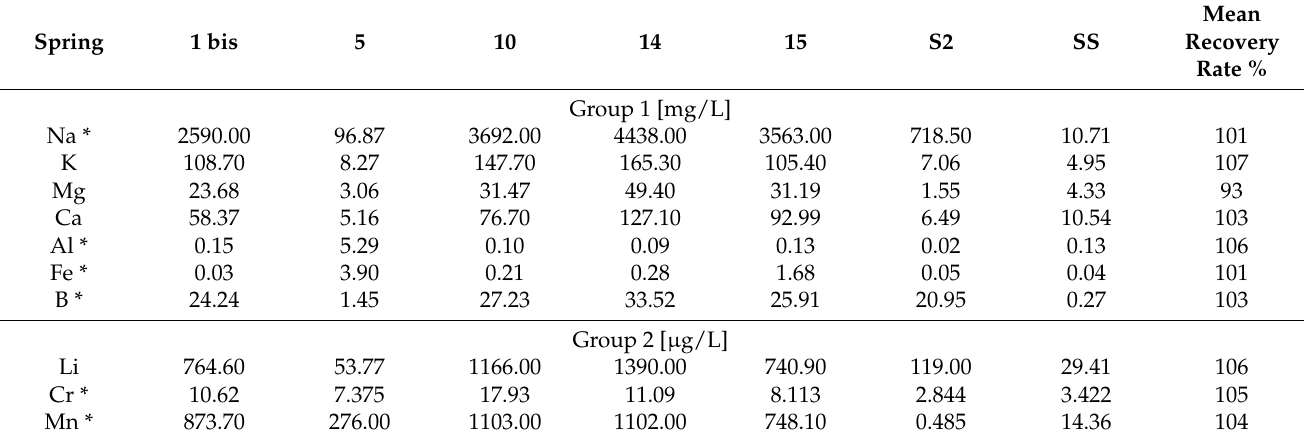
Table 4. Results of analyzed samples by